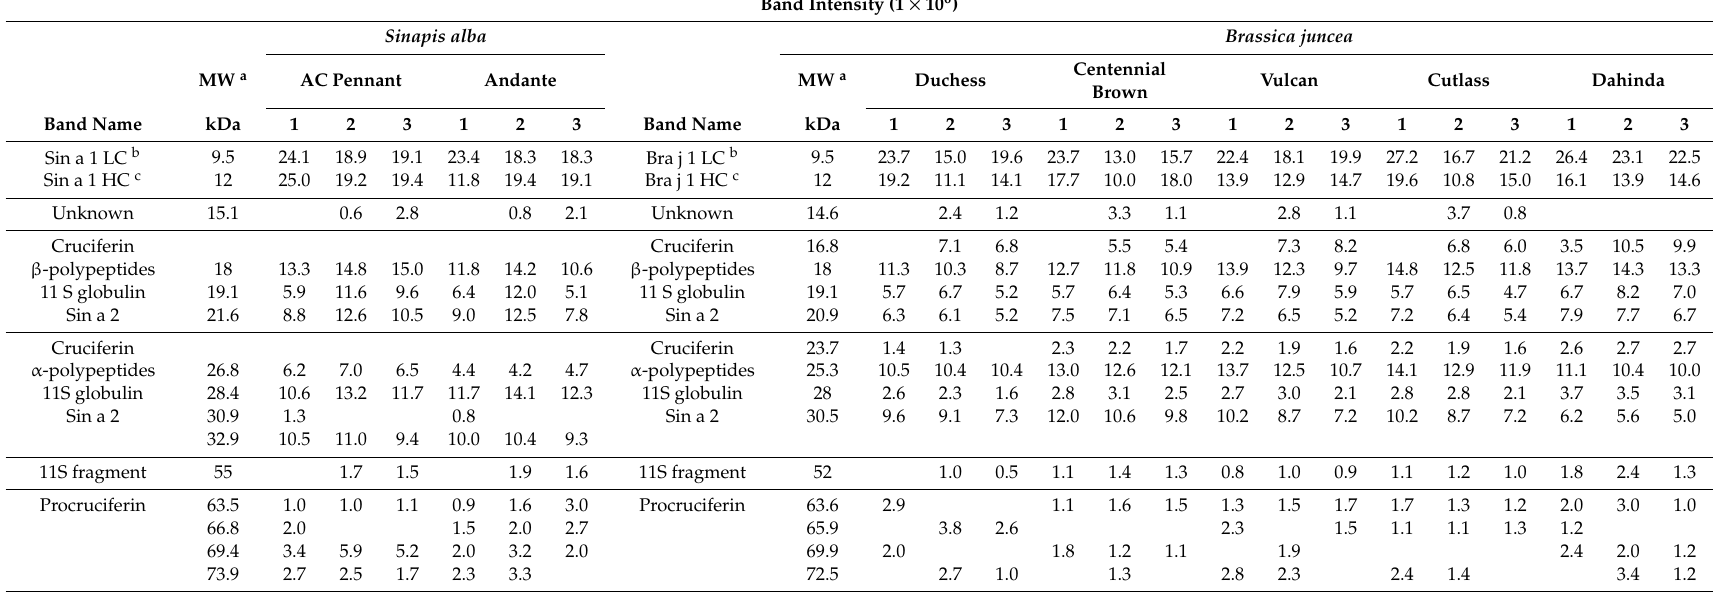
Table 1. Densitometry analysis of electrophoretic profiles of mustard protein